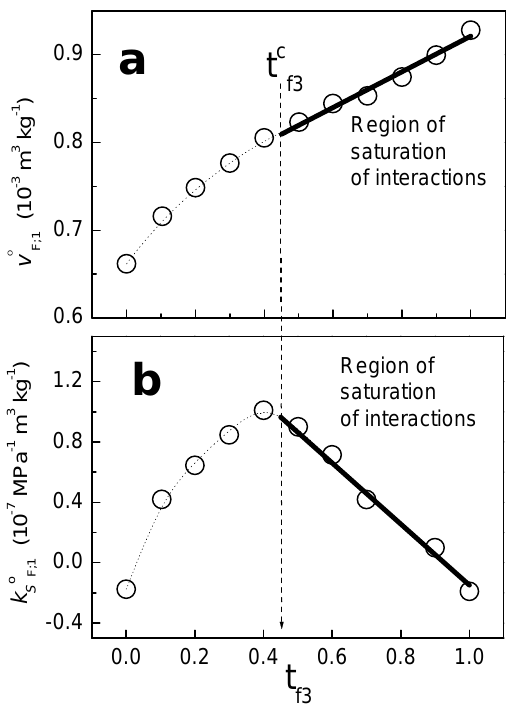
Figure 6. Specific partial volume at infinite dilution a) and specific partial adiabatic compressibility coefficient b) at infinite dilution in water at 30 ° C, of a fraction F composed of non-charged polymeric particles (component 2) and decyltrimethyl- ammnonium bromide (component 3) as function of the mass fraction of component 3 in the fraction F. The solid line represents the region in which the interactions are saturated (data taken from ref.